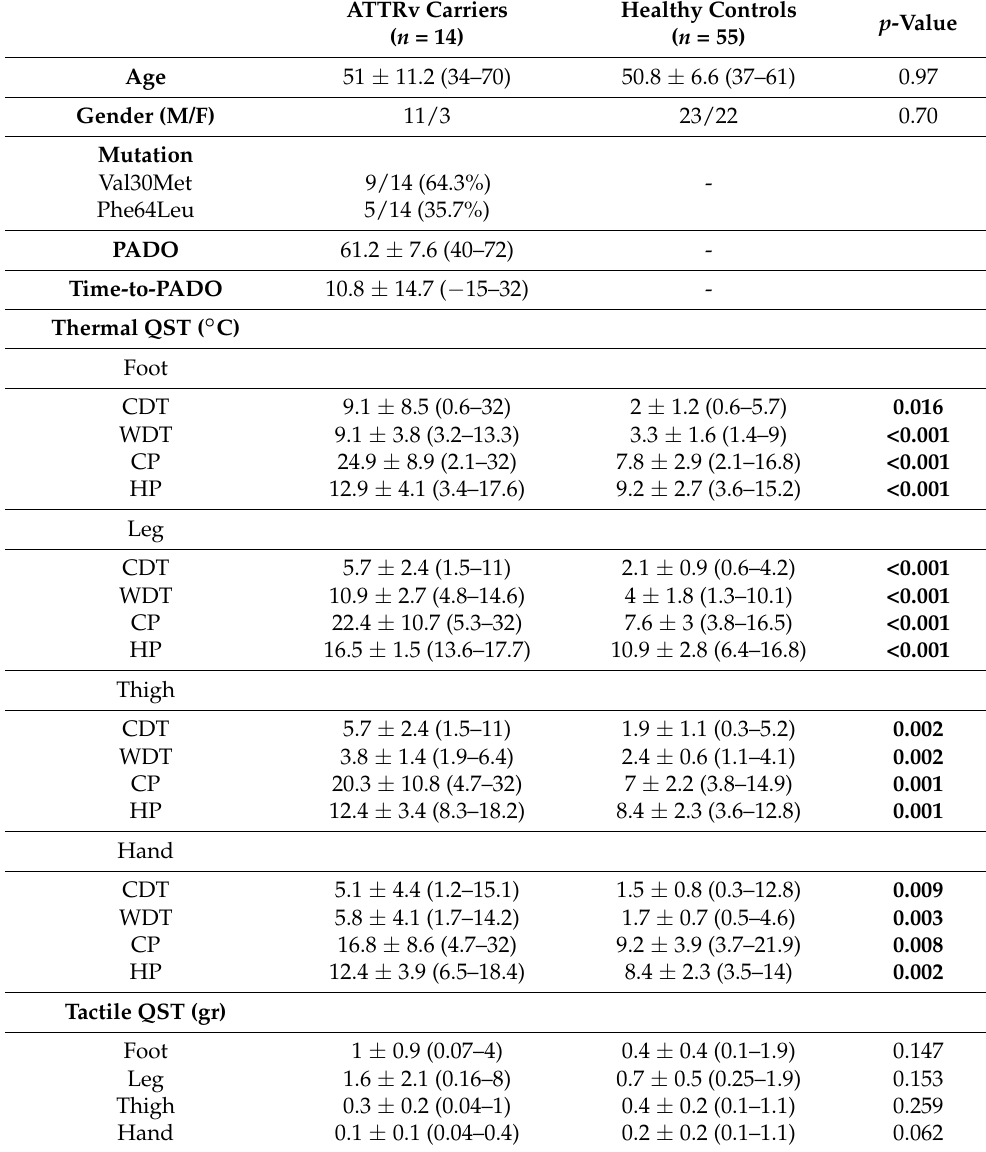
Table 1. Demographic and QST findings of ATTRv carriers and healthy controls.